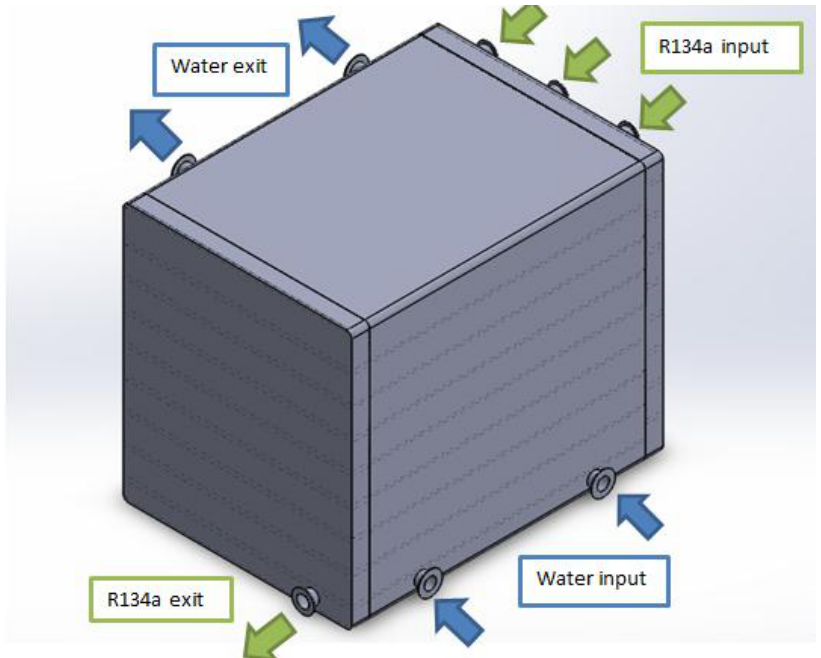
Figure 7. Scheme of inlet/outlet ports of the condenser.